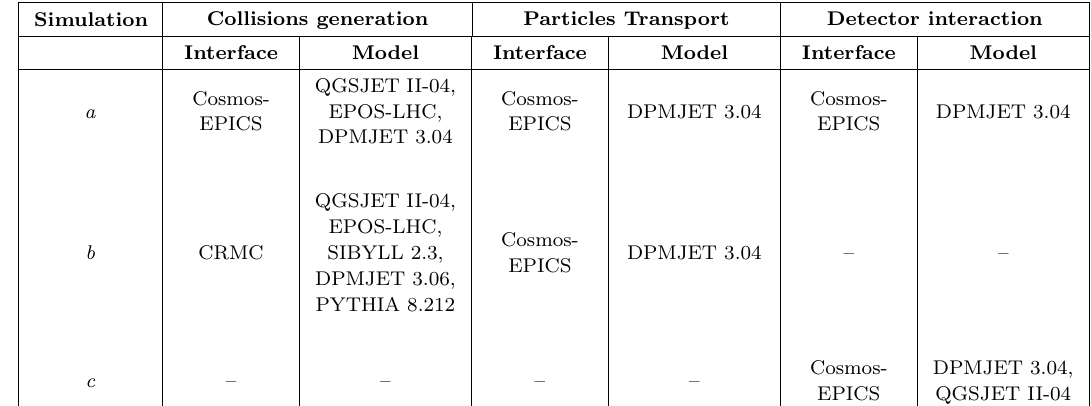
Table 1 . Summary of the three MC sets described in the text. The simulation is divided in three main steps: generation of particles produced in p-p collisions at secondary products from IP1 to the TAN region (taking into account the e(cid:11)ect of the magnetic (cid:12)eld, particle decays and particle interactions with the beam pipe), interaction of particles with the Arm2 detector. For each MC set we speci(cid:12)ed which software interfaces and which interaction models were used to simulate each step. The symbol \{" indicates that it was not necessary to simulate the given step for that MC